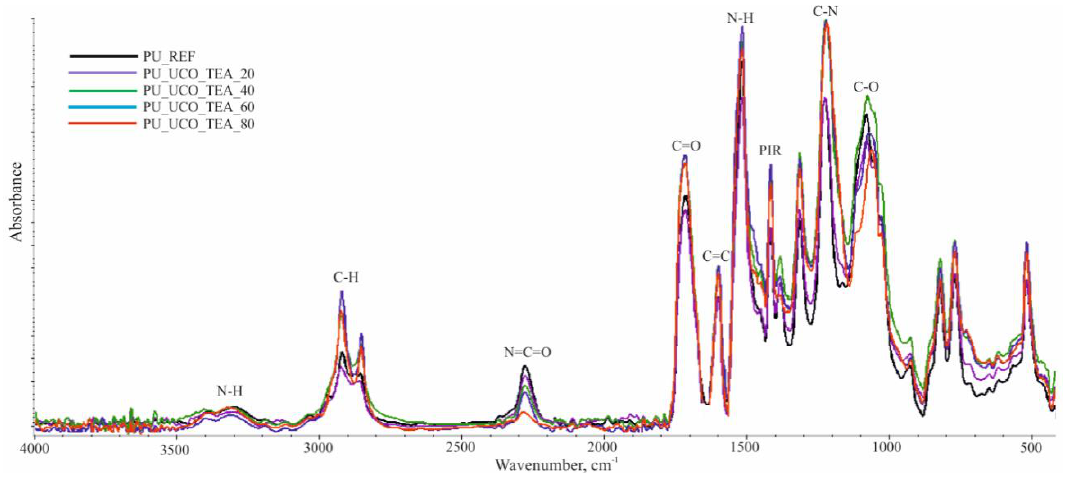
Figure 4. FTIR spectra of the reference material and PU_UCO_TEA_20–80 foams.